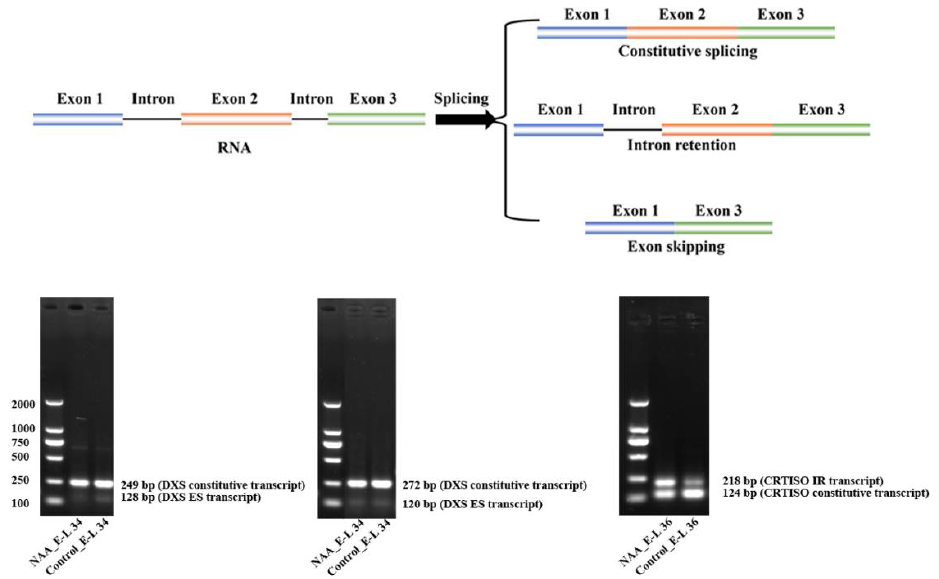
Figure 8. Qualitative RT-PCR analysis of expression of VviDXS and VviCRTISO splice variants in grape berries at specific stage under NAA100 and ABA1000 treatments. The forward and reverse primers were designed from the upstream and downstream exons of the skipped exon or reten- tion intron,